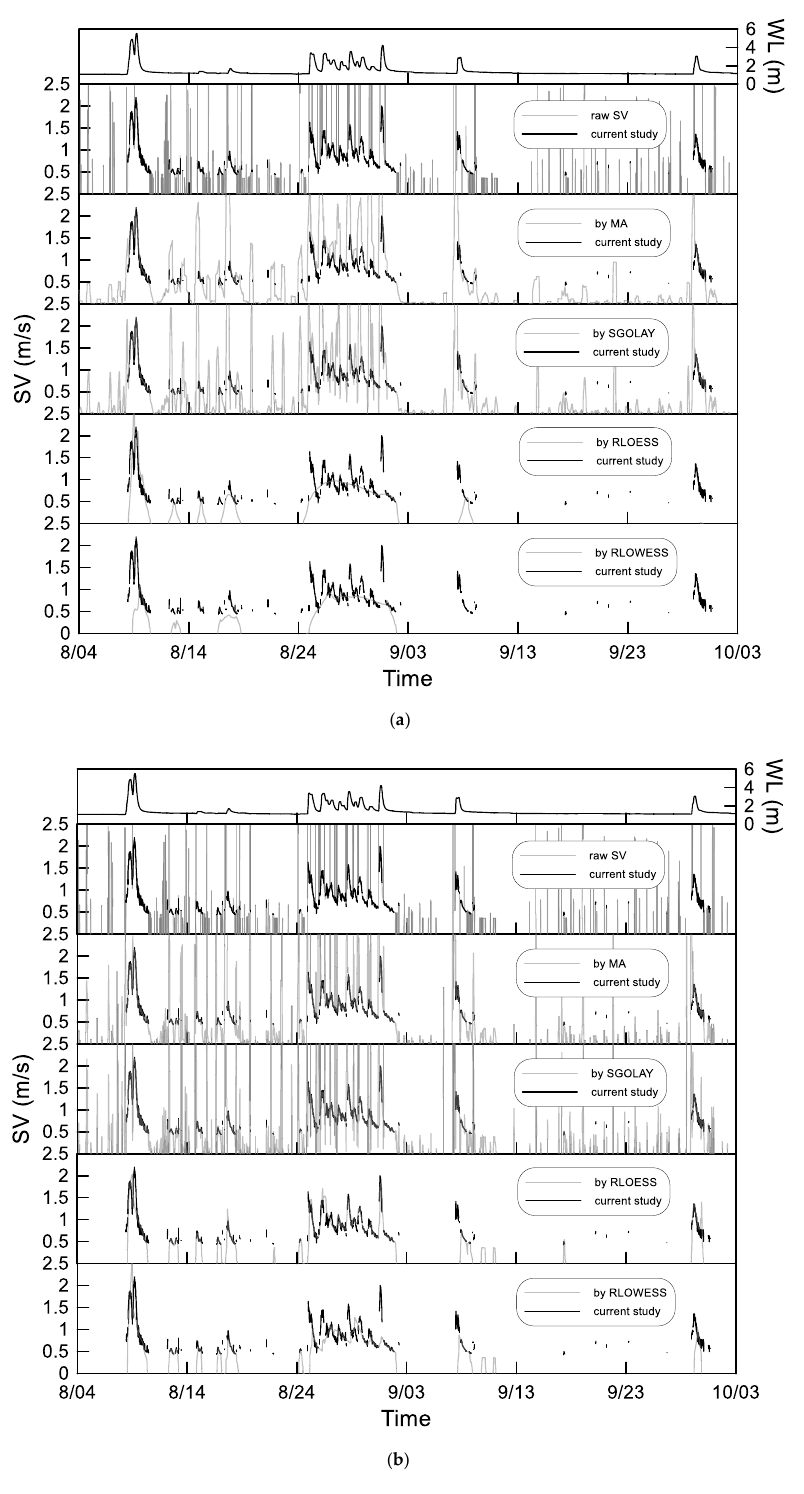
Figure 13. Comparison of the data filtered result with smoothing methods at Wulilin Bridge: ( a ) Bandwidth of 0.5%; ( b ) bandwidth of 0.1%.